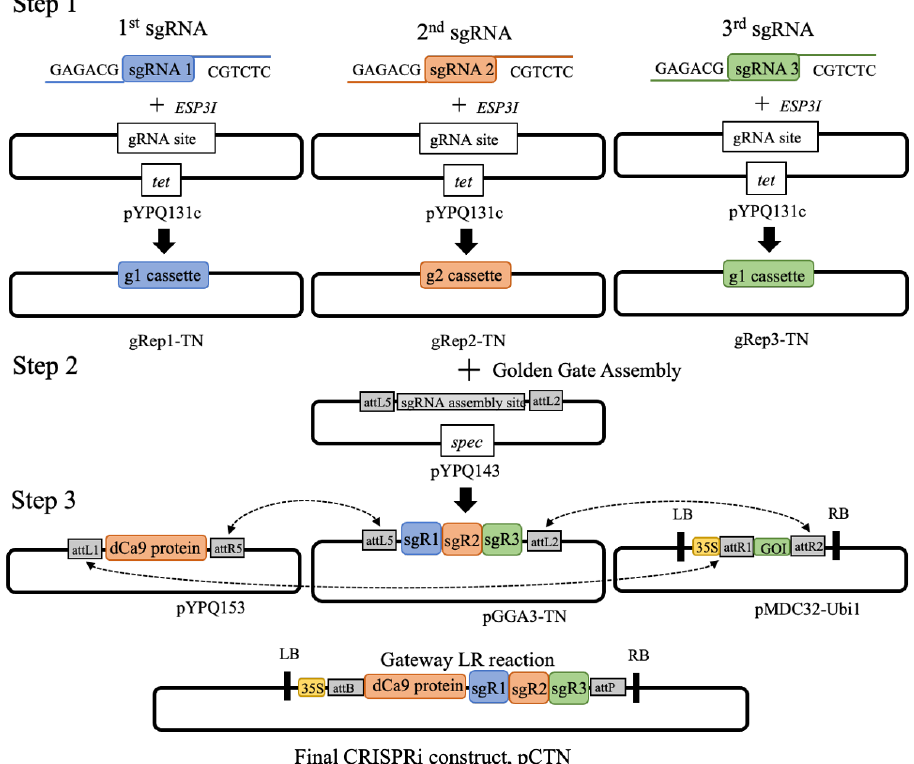
Figure 2. Illustration of the three-step cloning procedure for CRISPRi vector, pCTN, construction using Golden Gate assembly and Gateway LR reaction. Step 1 shows the cloning of individual gRNAs into a series of gRNA expression vectors (pYPQ131c, pYPQ132c, and pYPQ133c) that contain their own promoter. Step 2 involves the assembly of multiple gRNA expression vectors into one Golden Gate recipient vector, pYPQ143 (for three gRNA expression cassettes). Step 3 involves the final assembly of dCas9 vector and gRNA cassette into a single T-DNA binary vector (pMDC32-Ubi1) through Gateway recombination. LB, left border; RB, right border; spec , spectinomycin resistance marker; tet , tetracycline resistance marker; kan , kanamycin resistance marker; GOI, gene of insert.